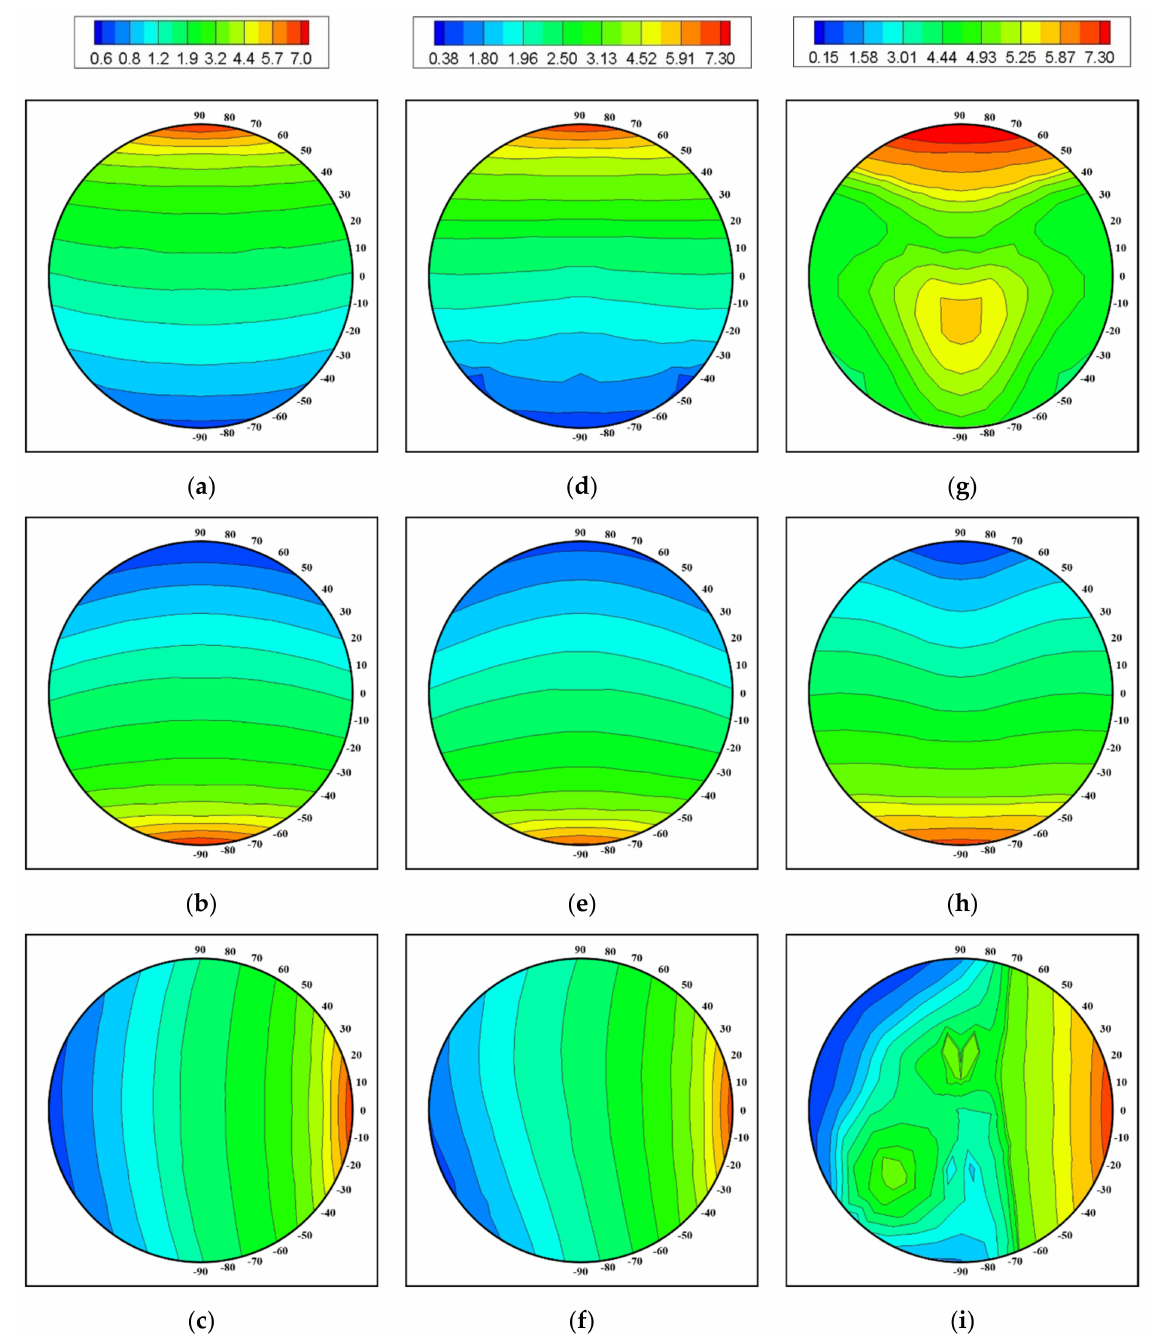
Figure 20. Contours of the top [1st row, ( a , d , g )], bottom [2nd row, ( b , e , h )] and right [3rd row, ( c , f , i )] surface-averaged Nusselt numbers for Ra = 10 3 (1st column), 10 4 (2nd column) and 10 5 (3rd